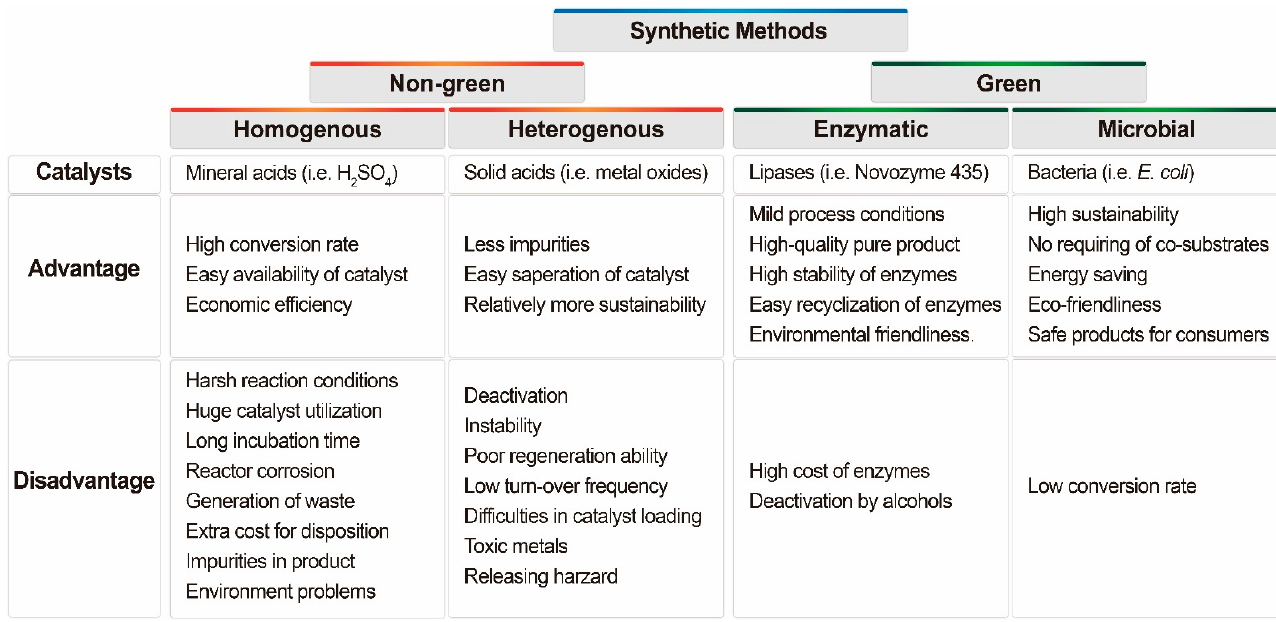
10 of 16 Table 1. Glycerol conversion rates achieved to date using different synthetic routes for acetins pro- duction. Synthetic Methods Type of Catalysts